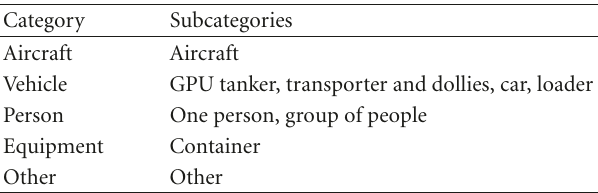
Table 5: Category of the objects and correspondent subcategories.